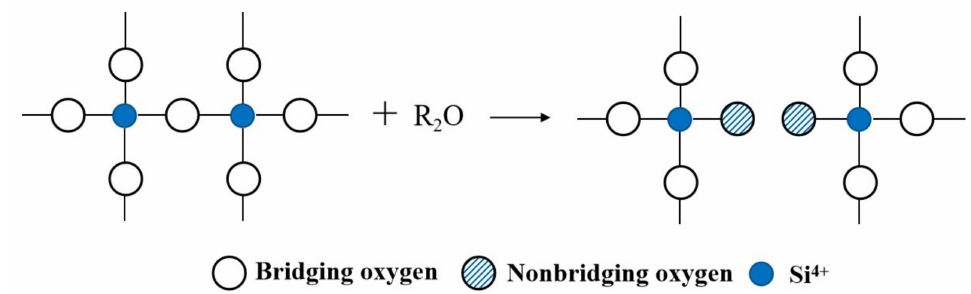
Figure 7. Schematic diagram of the breaking of oxygen bridge-bonding in the silicon-oxygen tetrahedron. The breaking of oxygen bridge-bonding leads to a change in the bond length, bond angle and bond strength of the Si-O bond, thereby changing the connection mode, re- sulting in the formation of small aggregates partially formed by the short chains of the silicon-oxygen tetrahedra, and the generation of small aggregates could directly affect the activation energy of particle migration of the modified blast furnace slag, resulting in a change in the fluidity. This process is not stable, and the small aggregates could interact and merge to release oxides, as shown in Equation